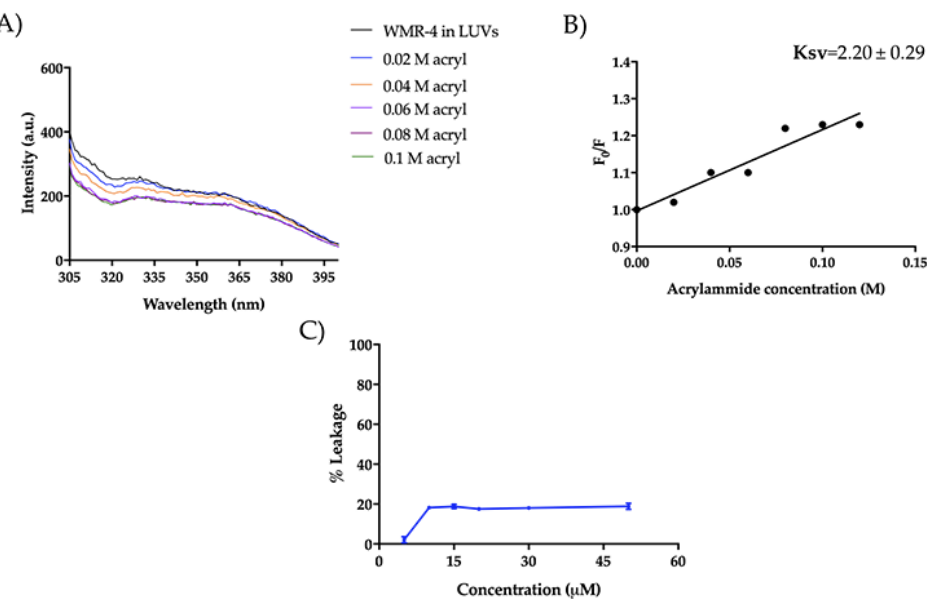
Figure 12. Tryptophan fluorescence spectra for the peptide WMR-4 in LUVs mimicking Gram- negative membranes during the quenching with acrylamide at different concentrations ( A ) and Stern–Volmer (Ksv) quenching constant ( B ). The leakage percentage of LUVs (DOPE/DOPG/CL) induced by WMR-4 ( C ).